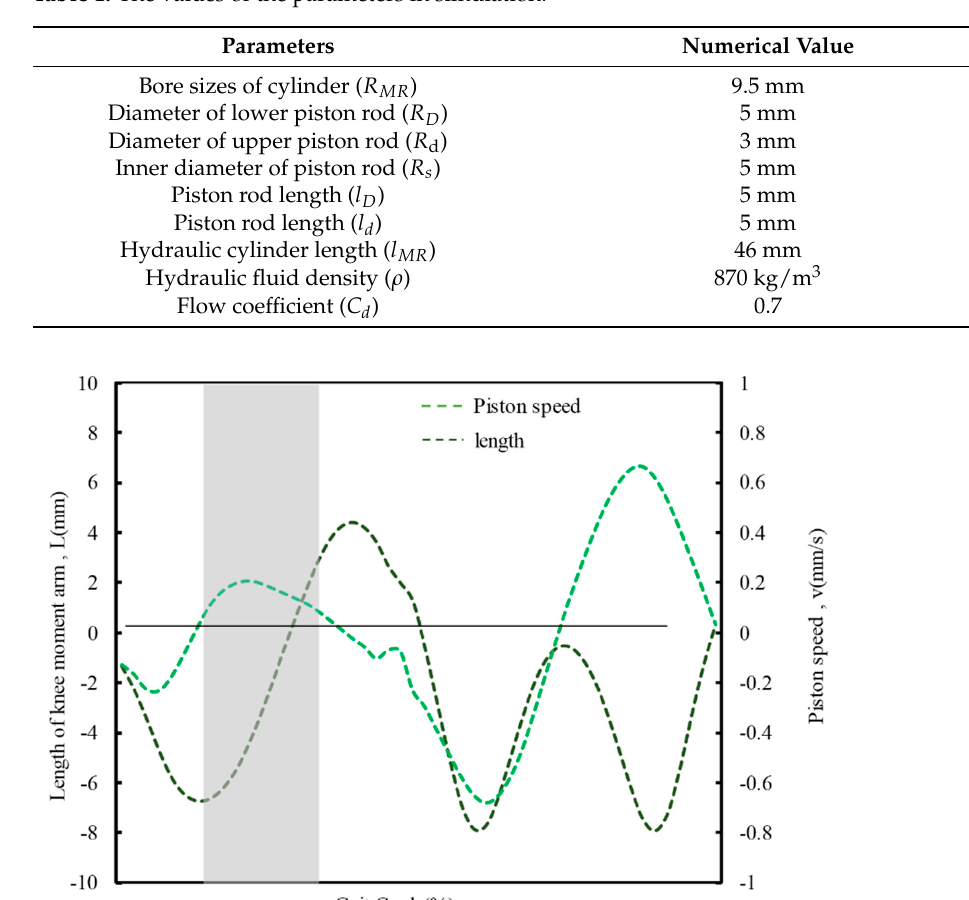
Figure 8. The velocity of the upper piston and the real-time moment arm of the prosthetic knee.